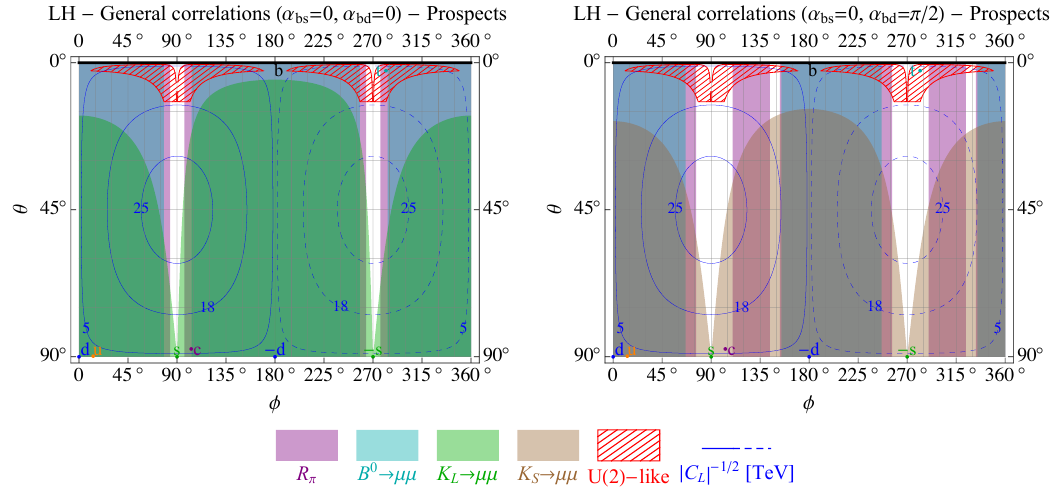
Figure 6 . Future prospects for the exclusion limits in the plane ( (cid:30); (cid:18) ) for two choices of the phases (cid:11) bs and (cid:11) bd from observables with direct correlation with R bound.